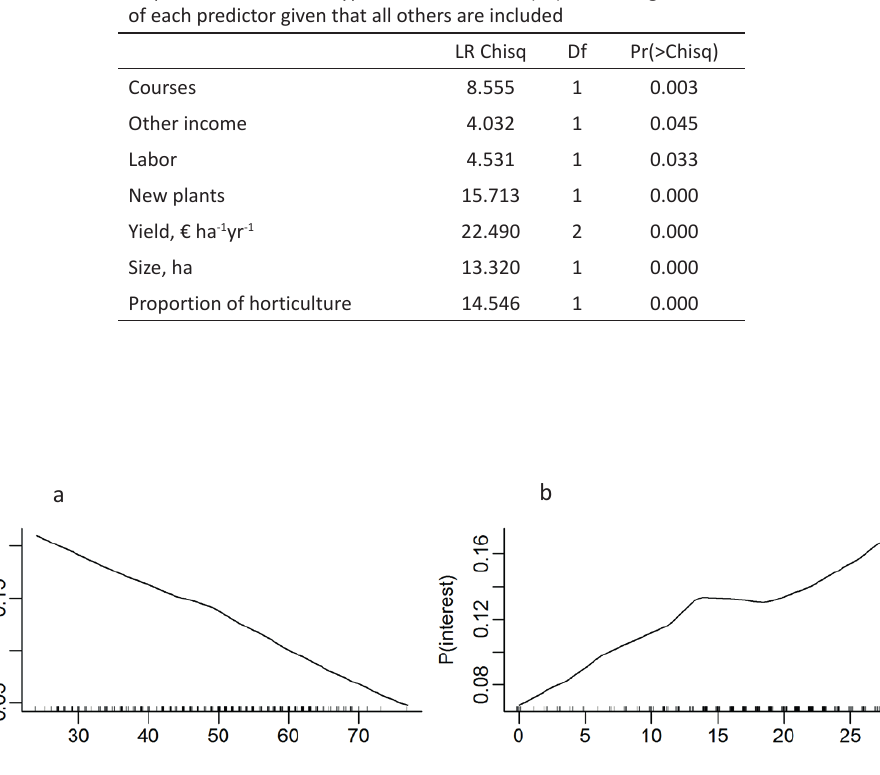
Fig. S1. Univariate non-parametric logistic regression model for the probability of interest in organic production with a) age of farmer ( Age ) and b) effort in developing the crop farming ( Development ) as explanatory variable. The tick-marks above the x-axis show the distribution of the explanatory variable.